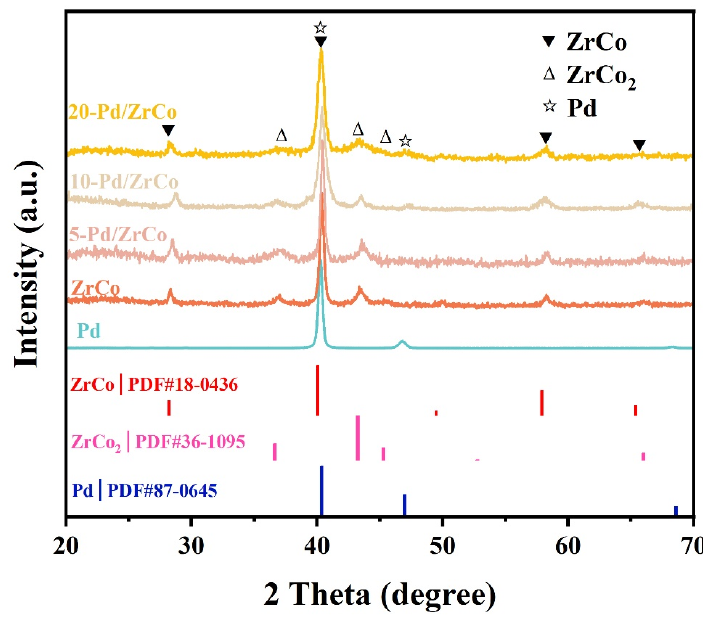
Figure 1. XRD patterns of the Pd, ZrCo, and Pd/ZrCo films.